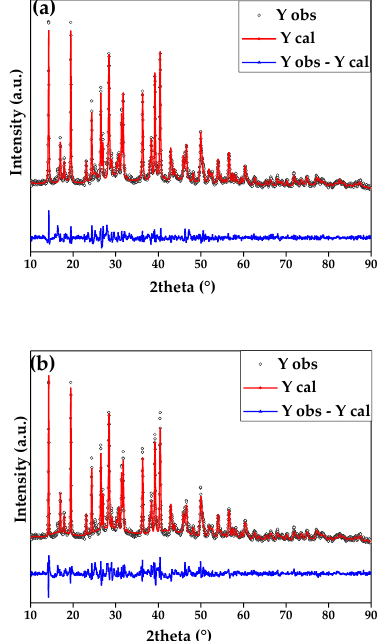
Figure 2. Rietveld refinement plot for ( a ) Au/calc-Sr sup and ( b ) Au/calc-Sr sup catalysts, showing the observed, calculated, and difference pattern.